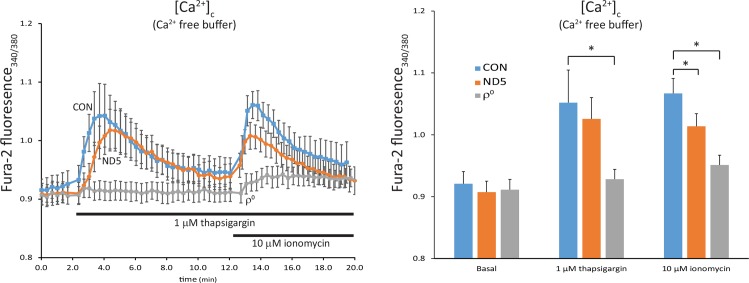
ND5 mutant mitochondria have reduced levels of stored calcium.Free cytoplasmic calcium [Ca2+]c was measured using the ratiometric dye fura-2 AM on an epifluorescence imaging system. Thapsigargin was used to block the Ca2+-ATPase to release endoplasmic reticulum (ER) calcium stores, followed by the addition of ionomycin to release mitochondrial calcium. Calcium release from ER stores was not different between control (CON) cybrids and ND5 mutant cybrids, but was significantly reduced in ρ0 cells. However, calcium release from mitochondrial stores was significantly lower in ND5 mutant cybrids lower (66.4 ± 15.8%) that CON cybrids. Stored mitochondrial calcium was also significantly lower in ρ0 cells compared to CON cybrids (21.3 ± 11.7%). Data is mean ± s.d. n = 3.*p<0.05.